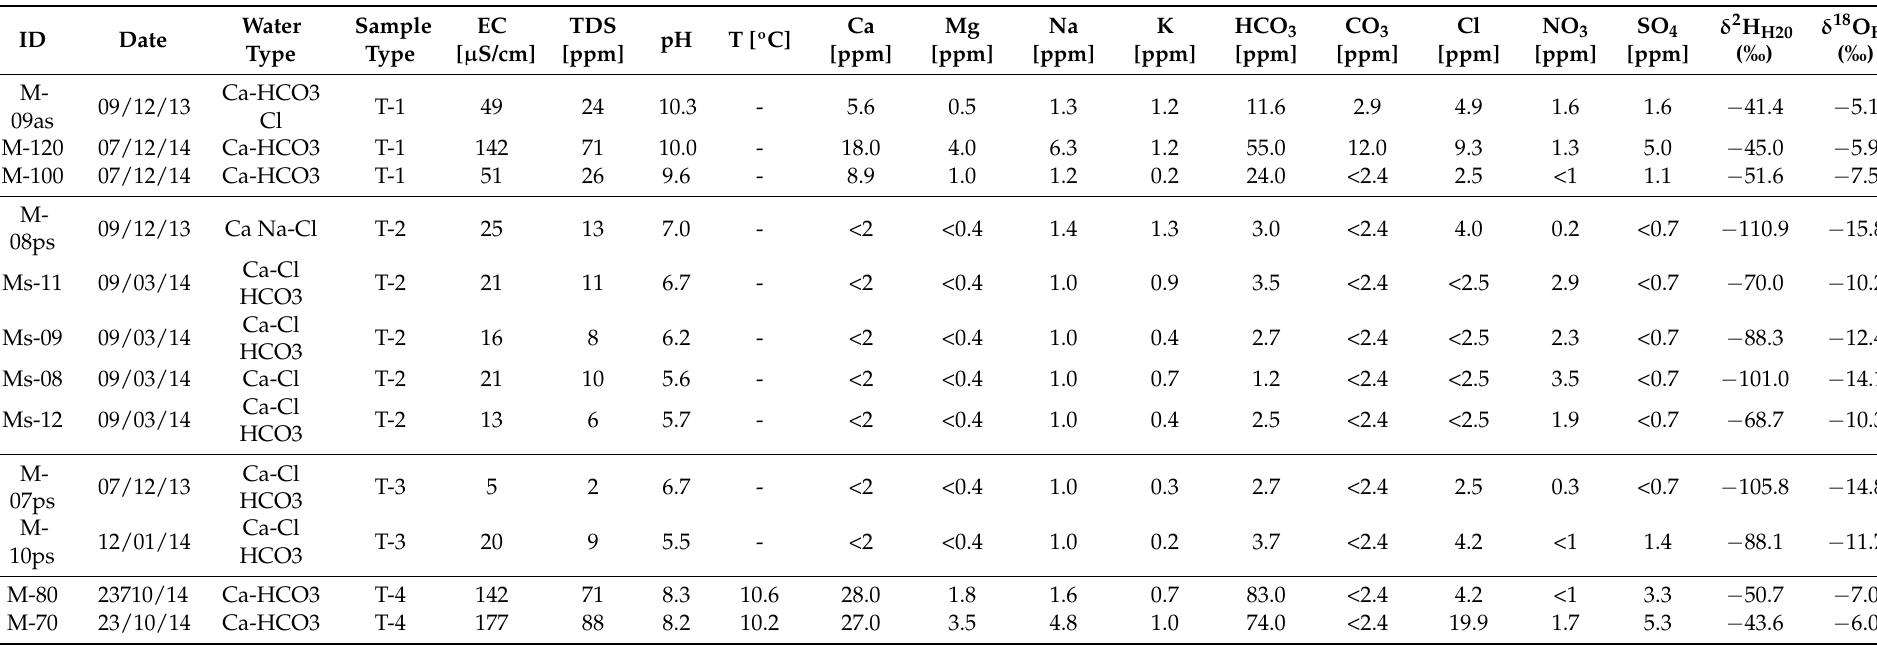
Table A4. Chemical characteristics of major constituents for the 10 snow samples (7 natural and 3 artificial) and 2 water ponds. (samples type T-1 correspond to artificial snow (snow gun); T-2 natural snow (inside sky trail); T-3 natural snow (outside sky trail); and T-4 water ponds for artificial snow